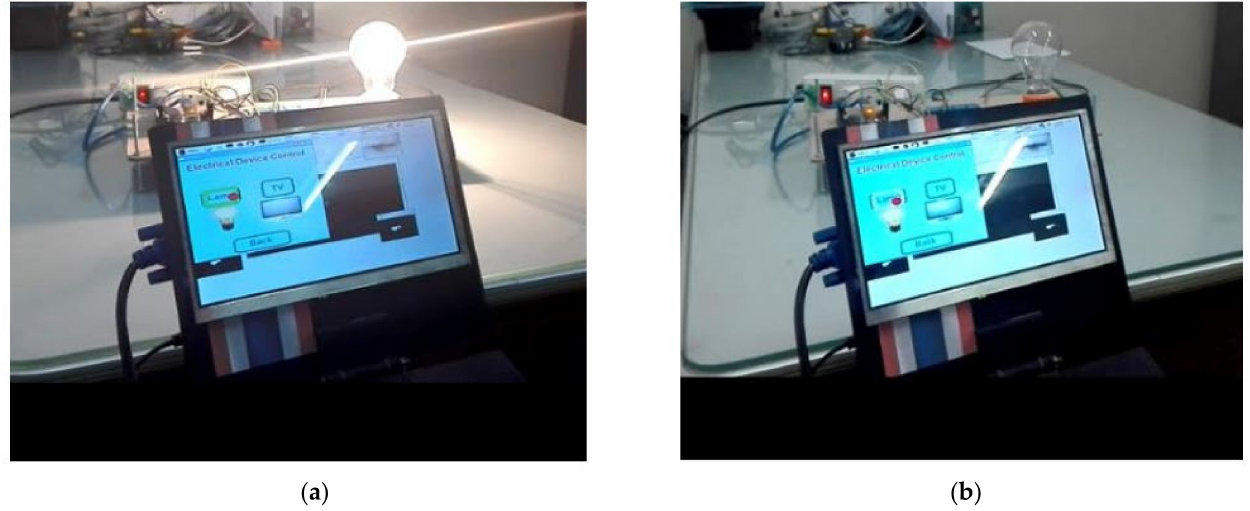
Figure 15. Mobile assistive system controlling appliance. ( a ) Turning on lamp; ( b ) turning off